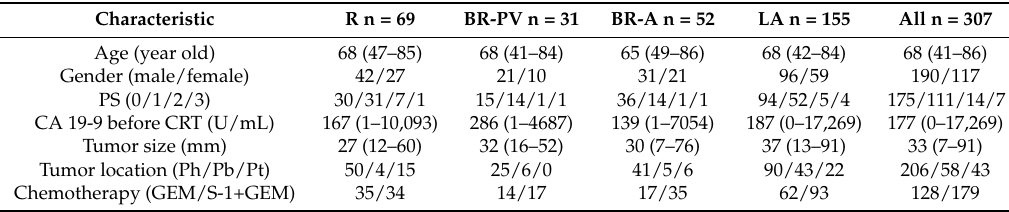
Table 1. Characteristics and backgrounds of the 307 PDAC patients enrolled for CRTS in each resectability